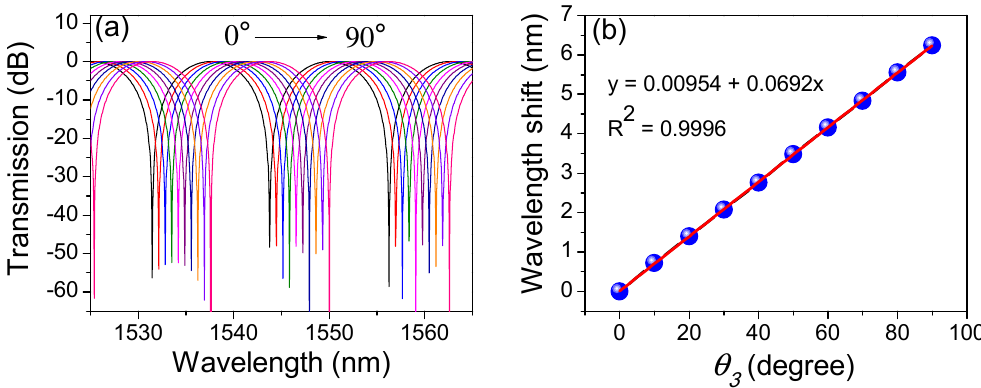
Figure 5. ( a ) Numerical simulation of the spectral evolution with the varied θ 3 and ( b ) the relationship Figure 5. (a) Numerical simulation of the spectral evolution with the varied 𝜃 (cid:2871) and (b) the between wavelength shift and θ relationship between wavelength shift and 𝜃 (cid:2871)